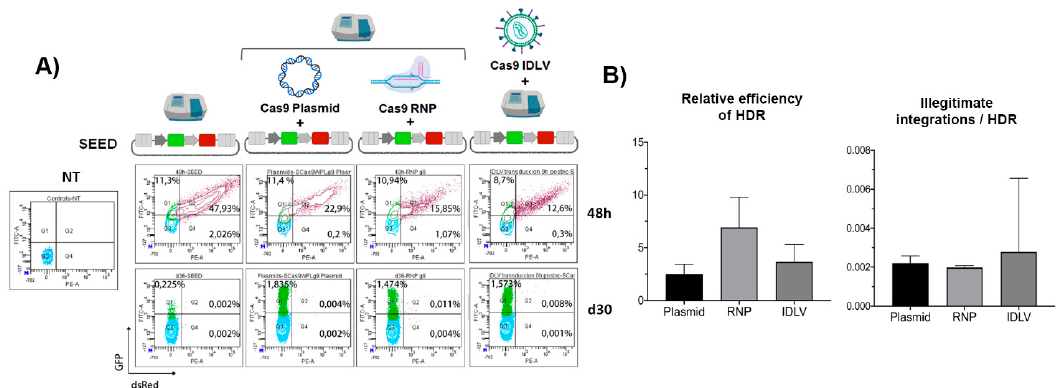
Figure4. CRISPR / Cas9deliverysystemsachievedsimilare ffi Figure 4. CRISPR/Cas9 delivery systems achieved similar efficacies and specificities of HDR in K562GWP model. ( A ) Representative cytometry plots showing the differential fluorescence patterns